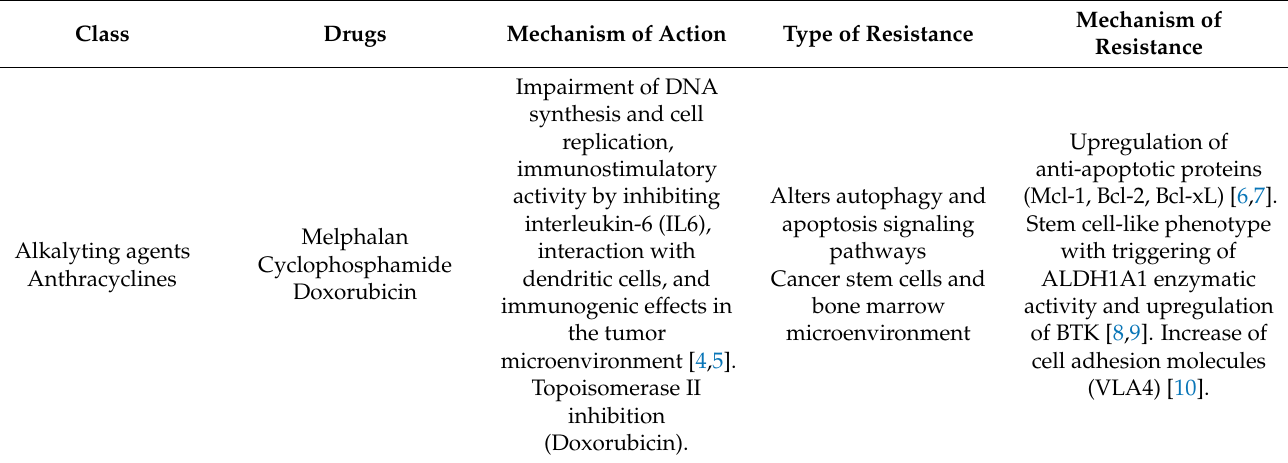
Table 1. Mechanism of action and underlying drug resistance mechanisms of the common chemo- therapeutic agents.